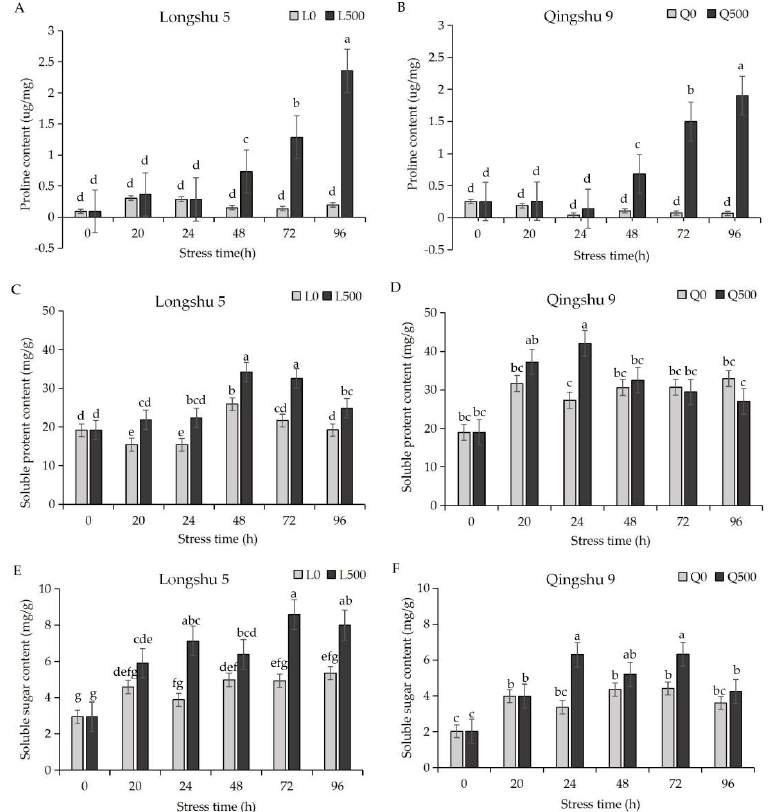
Figure 1. Proline, soluble protein, and soluble sugar responses to salt stress. “L0” and “L500” represented Longshu5 and was exposed to 0 mmol/L and 500 mmol/L NaCl stress, respectively. “Q0” and “Q500” represented Qingshu9, with exposure to 0mmol/L and 500mmol/L NaCl stress, respectively. ( A ) ‘Longshu 5’ proline content, ( B ) ‘Qingshu 9’ proline content, ( C ) ‘Longshu 5’ soluble protein content, ( D ) ‘Qingshu 9’ soluble protein content, ( E ) ‘Longshu 5’ soluble sugar content, and ( F ) ‘Qingshu 9’ soluble sugar content were measured at 0, 20, 24, 48, 72, and 96 h. Gray and black columns show 0 and 500 mmol/L NaCl concentrations, respectively. Values are means and bars indicate SDs ( n = 3). Same lowercase letters mean no significant difference, different lowercase letters mean significant difference.